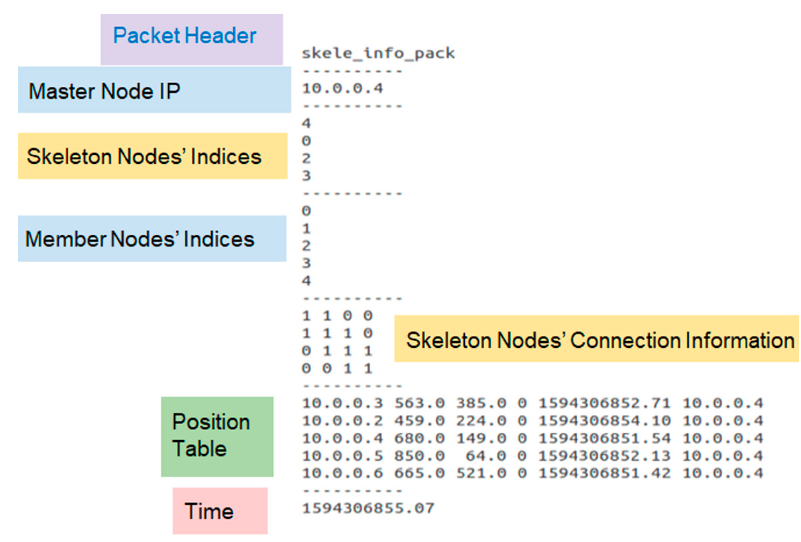
Figure 13. Format of SIP.